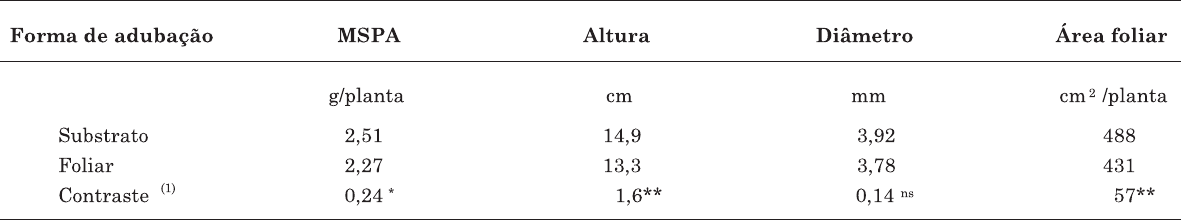
Quadro 2. Contrastes dos valores estimados para produção máxima da matéria seca da parte aérea (MSPA), altura, diâmetro da haste e área foliar de mudas de cacau, de acordo com a forma de adubação, aos 145